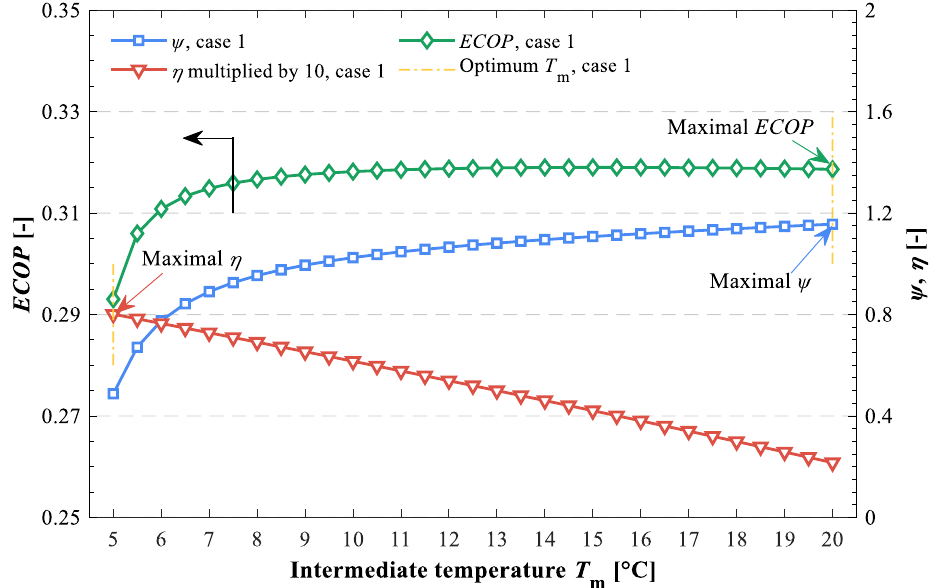
Figure 6. Effect of intermediate temperature on performance indicators for the layout with a cascade subcooling process in case 1.